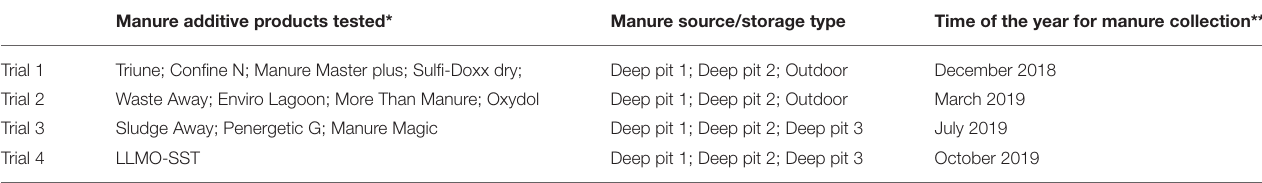
TABLE 1 | Summary of four, 8-week long Trials to test the effectiveness of additive products for mitigation of gas emissions from stored swine manure. Manure additive products tested*